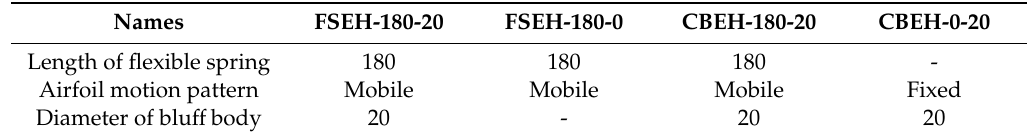
Table 3. Names of di ff erent